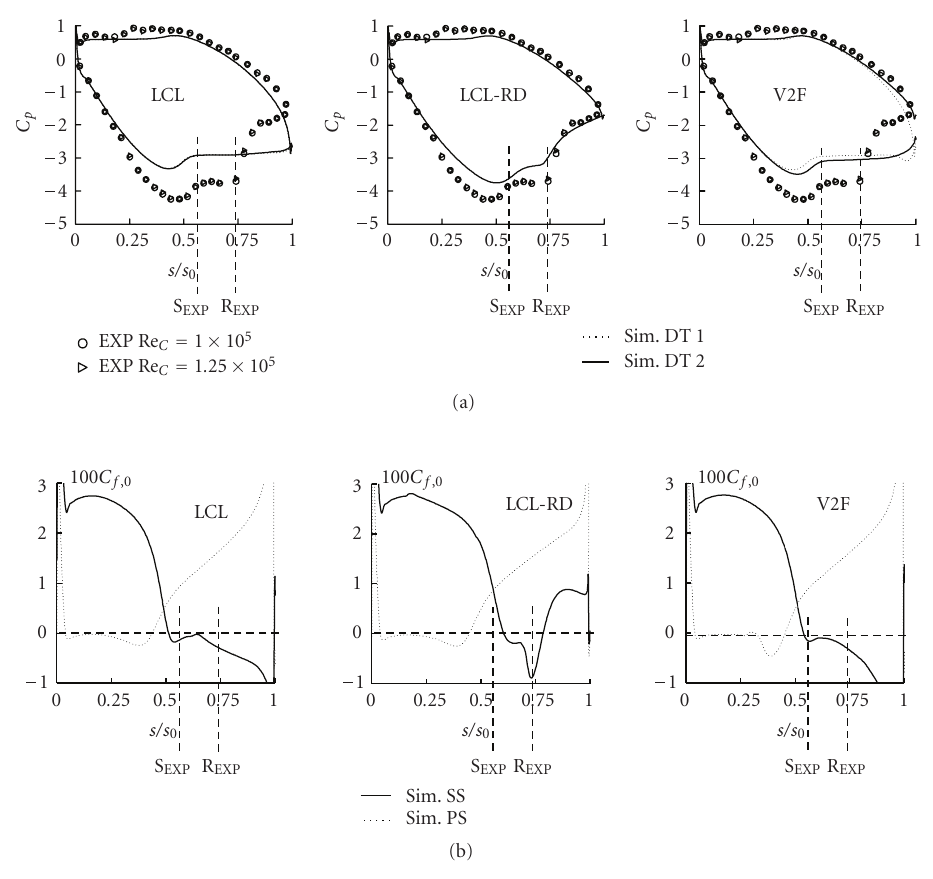
Figure 7: Pressure coe ffi cient and wall shear stress coe ffi cient for di ff erent turbulence models for the undisturbed